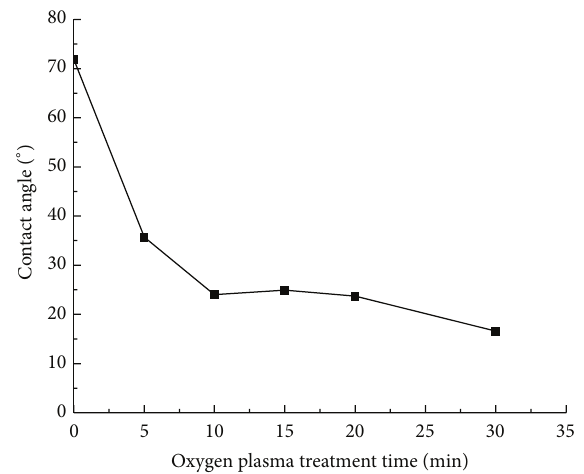
Figure 4: Contact angle curves of PLGA films after two kinds of UV irradiation